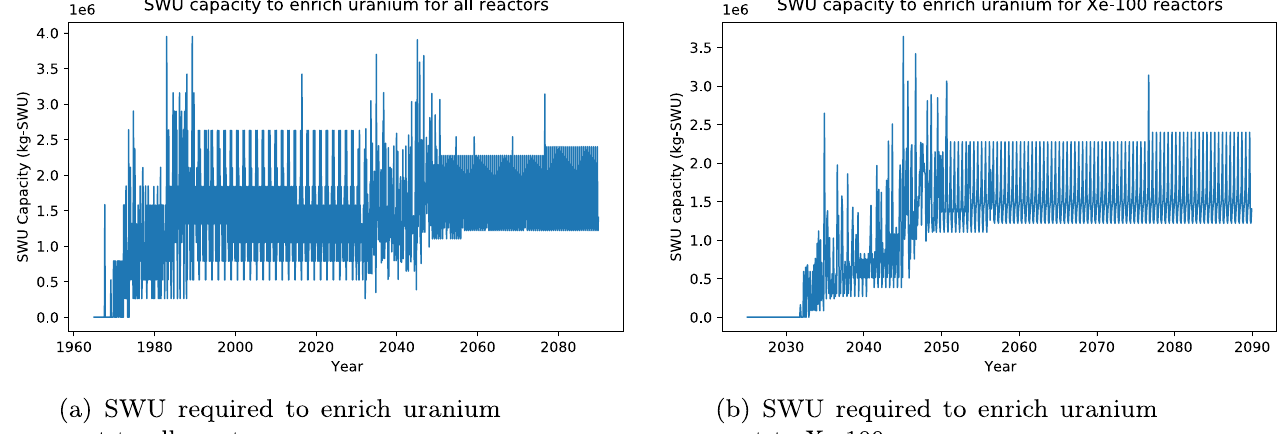
Fig. 9. Enriched uranium mass sent to reactors in Scenario 3.